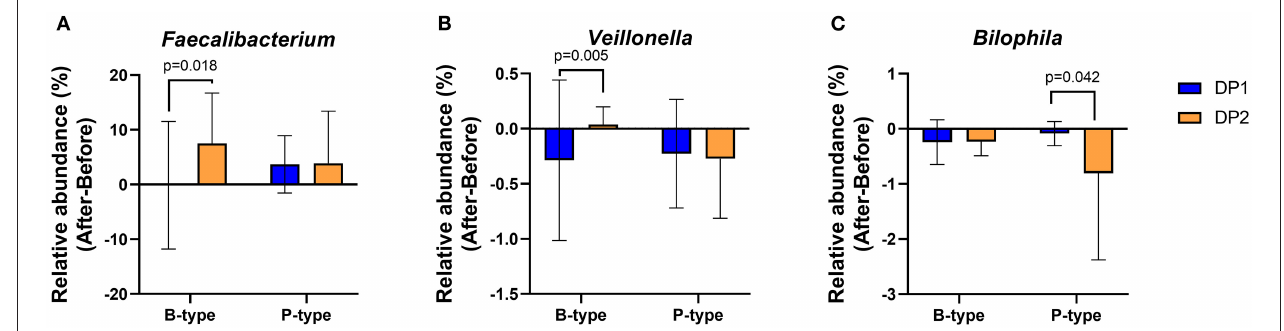
FIGURE 6 | Changes in gut microbial composition after Saengshik supplementation according to enterotype and dietary-pattern clusters. Changes in the relative abundance of (A) Faecalibacterium , (B) Veillonella , and (C) Bilophila according to enterotype and habitual dietary-pattern group. The vertical axis shows the alternation of relative abundance, which is the delta value between the relative abundance (%) of samples before and after the intervention in each dietary pattern and enterotype group (After minus Before in B-type with DP1, B-type with DP2, P-type with DP1, and P-type with DP2). P -values according to multiple t -tests were adjusted by the Benjamini–Hochberg false discovery rate (q < 0.05). B-type: DP1 ( n = 20) and DP2 ( n = 23). P-type: DP1 ( n = 11) and DP2 ( n =